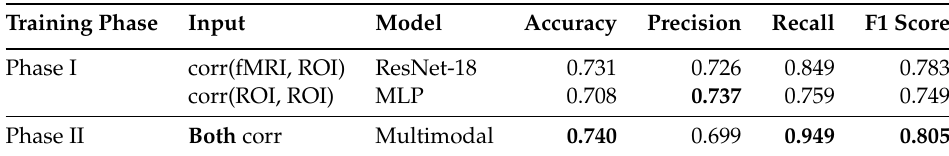
Table 2. Results and performance metrics. Classification accuracy, precision, recall, and F1 scores for both feature extractor networks and final end-to-end multimodal